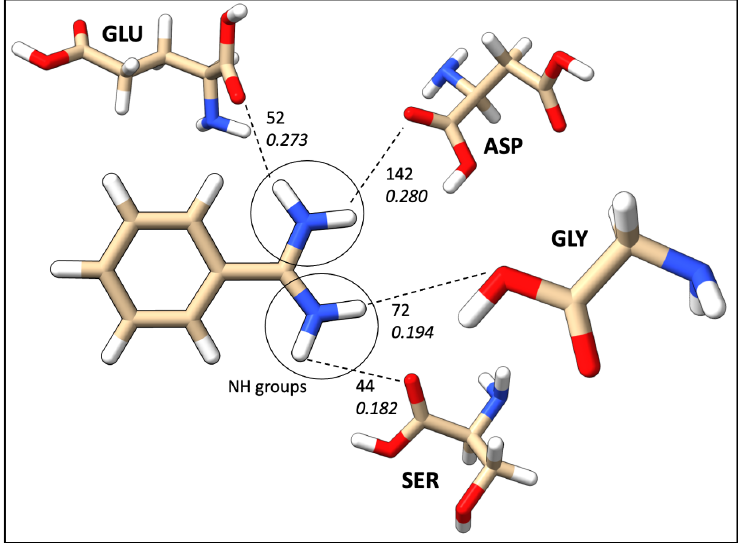
Figure 11. Frequent HBs interactions between the N–H ligand functional group and amino acid residues; the top numerical value mentions the number of HBs, and the bottom value represents the average strength in mDyn/Å from database B.